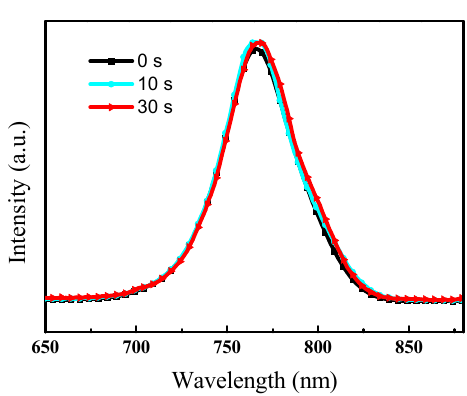
Figure A1. PL spectrum of FTO/TiO 2 /MAPbI 3 with different ethanol vapor treatment times.